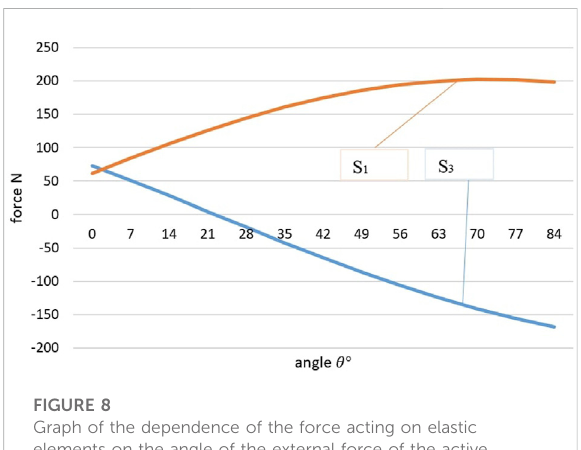
Graph of the dependence of the force acting on elastic elements on the angle of the external force of the active manipulator.